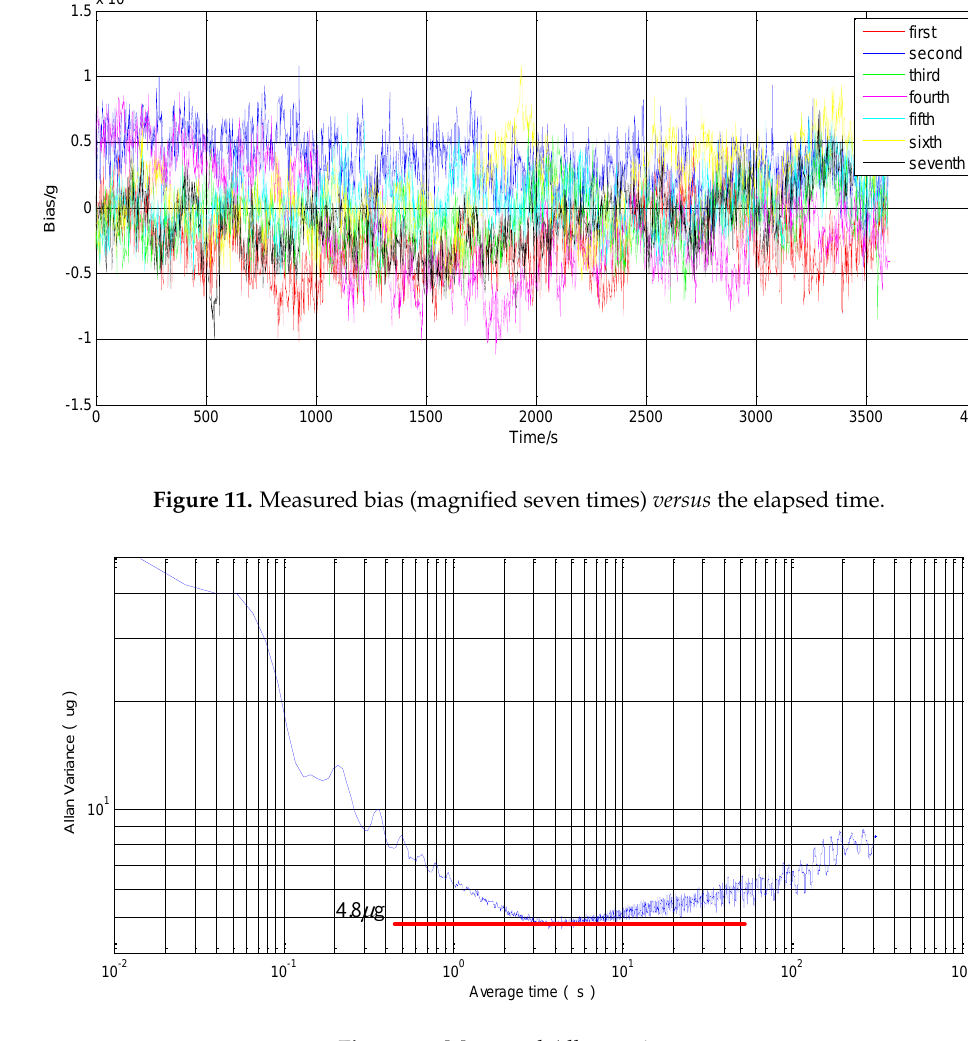
Figure 12. Measured Allan variance.